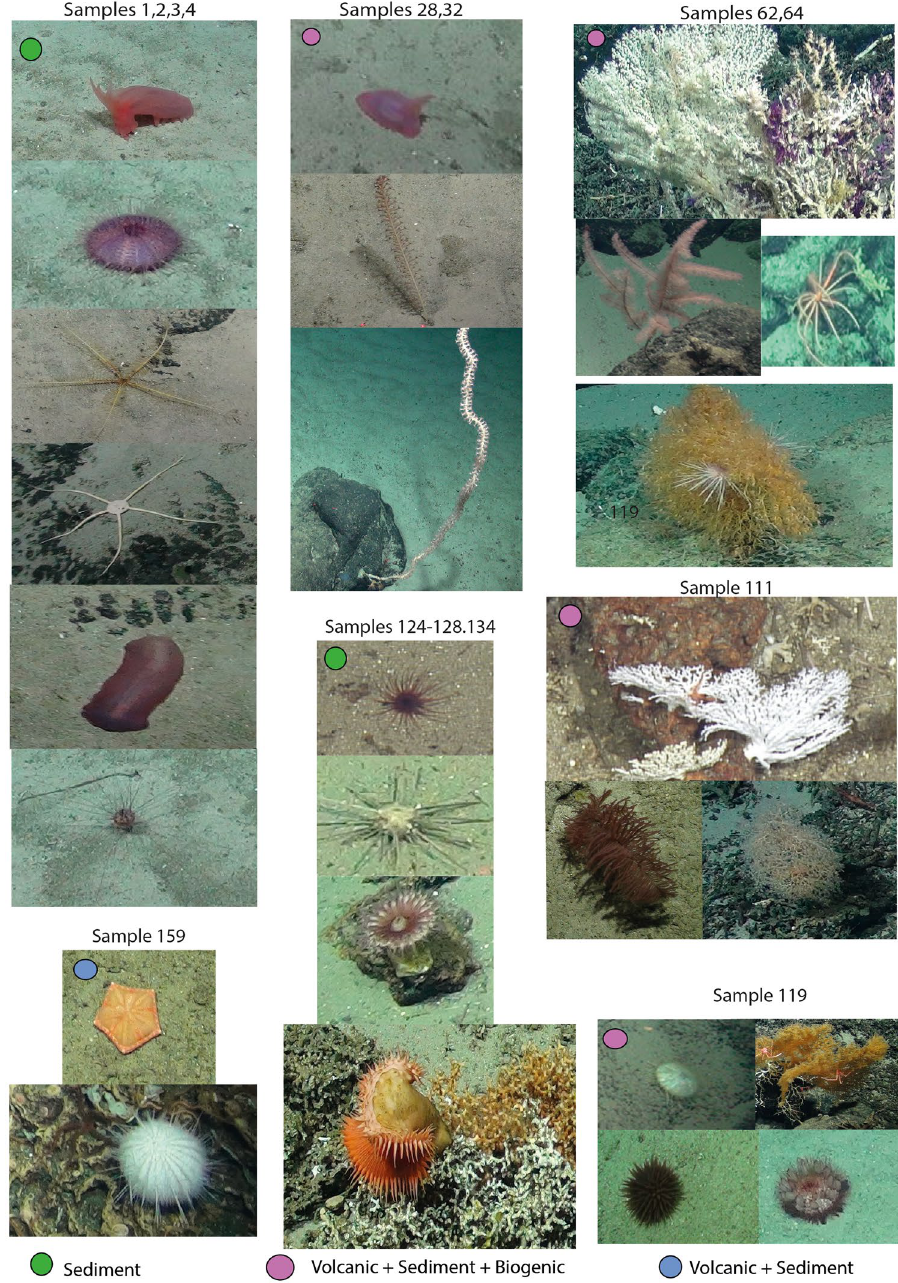
Figure 4. Examples of the communities of the significant Local Contribution to Beta Diversity samples with their corresponding habitats. The species names are per sample grouping from left to right and then from top to bottom. Samples 1,2,3,4 - Peniagone or Amperima sp., Pink echinothurioid, Comatulidae, Ophiomusium sp., Benthodytes sp. and Aspidodiadema sp.; samples 28, 32 - Ellipinion sp., Funniculina sp., Isididae whip; samples 62,65 - Corallium sp. and Clavularia sp., Parantipathes sp., Brisingidae, Acanella sp.; sample 111 - Stylasterid, Bathypathes sp. and Chrysogorgid.; sample 119 - white echinohurioid, Leiopathes sp., Liponema sp., Phormosoma sp.; samples 124–128,134 - brown cerianthid anemone, Cidaris cidaris , purple cerianthid anemone, Hormathiidae on Solenosmilia variabilis ; sample 159 - Plinthaster sp. and Urchin white